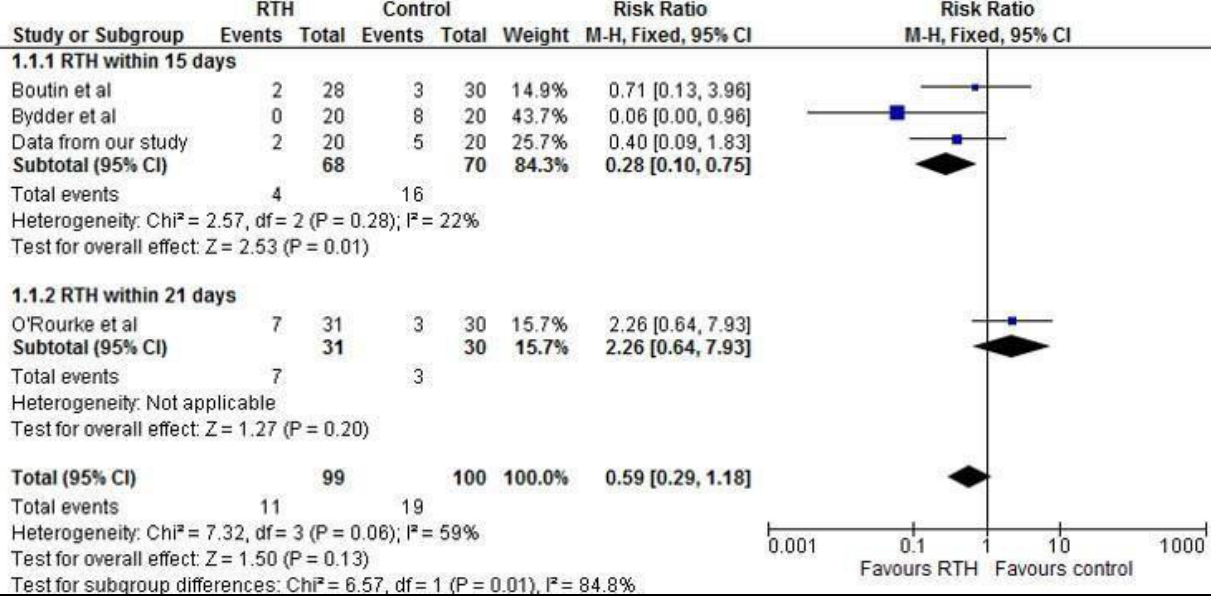
Figure 3: Forest plot of the efficacy of prophylactic radiotherapy (RTH) in reducing procedure tract metastasis. control group (7% vs. 10%, respectively). However, this difference was not significant. It should not escape our notice that they used a different RTH regimen (10-Gy single fraction using 9